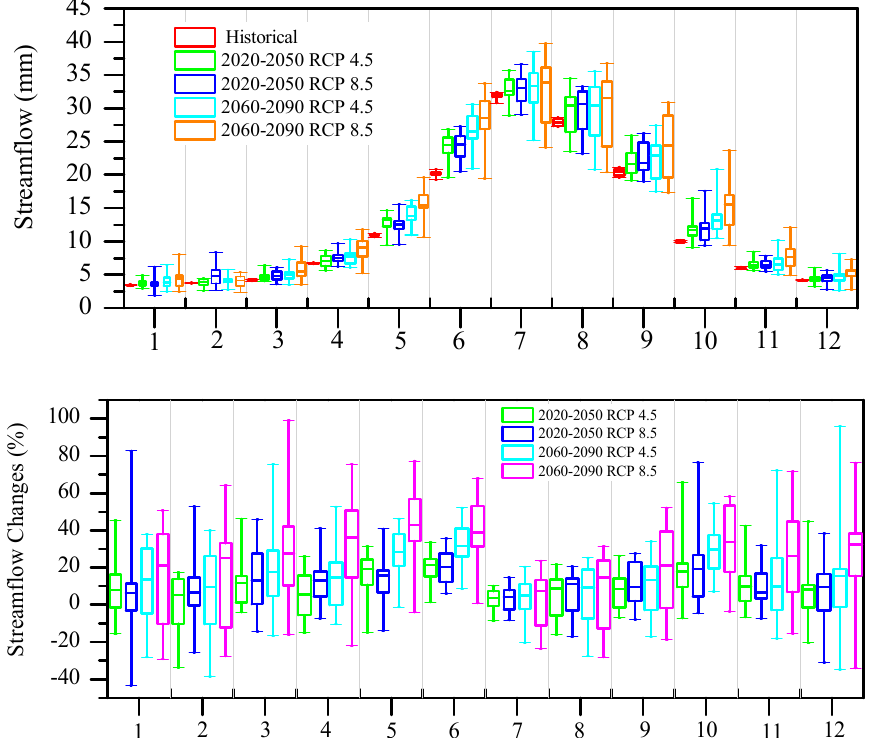
Figure 10. Monthly streamflow and percentage change relative to 1961–2005 under RCP scenarios 4.5 and 8.5. In the box plot, the upper and lower hinges represent the 75th and 25th percentiles, respectively. The whiskers show the other data points, except for the outliers. The line within the box shows the median.